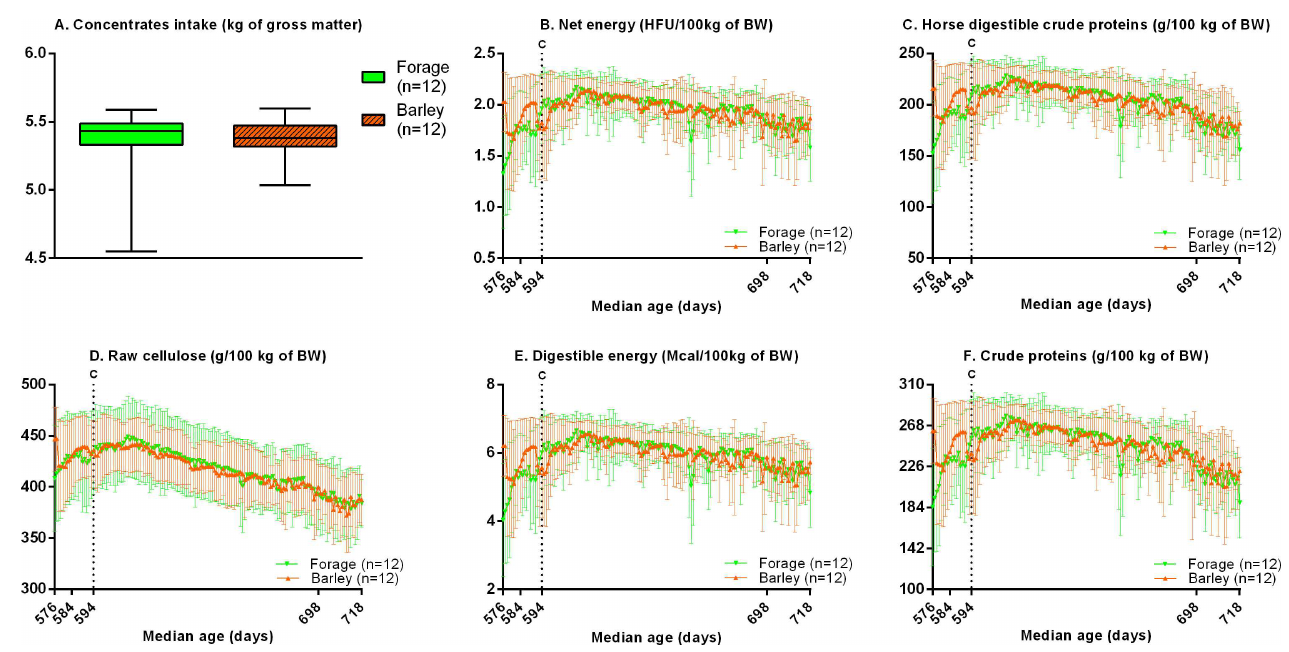
Fig 3. Daily feed intake (median and IQR) in terms of kg of brute matter of concentrates (A), net energy (B), estimated digestible energy (C), horse digestible crude proteins (D), crude proteins (E) and raw cellulose (F) during the feeding challenge of overnutrition. HFU: horse feed units, BW: Bodyweight, C: Beginningof the